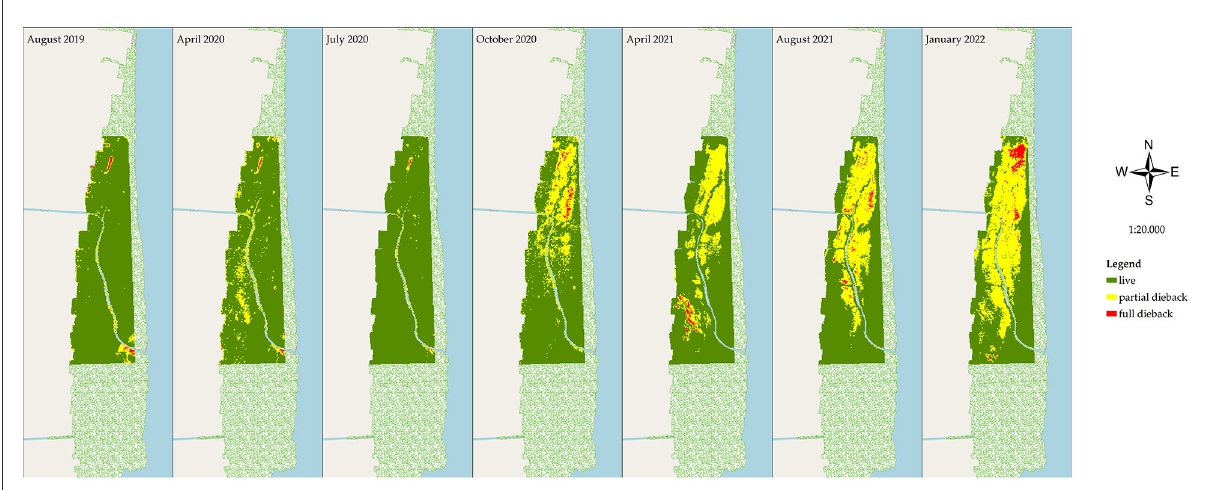
FIGURE4 Results from PSRI analysis of the mangrove condition in East Lampung, Sumatra, in different months in August 2019–January 2022 (map base: ESRI OpenStreetMap by ArcMap 10.8, accessed on March 12, 2022).